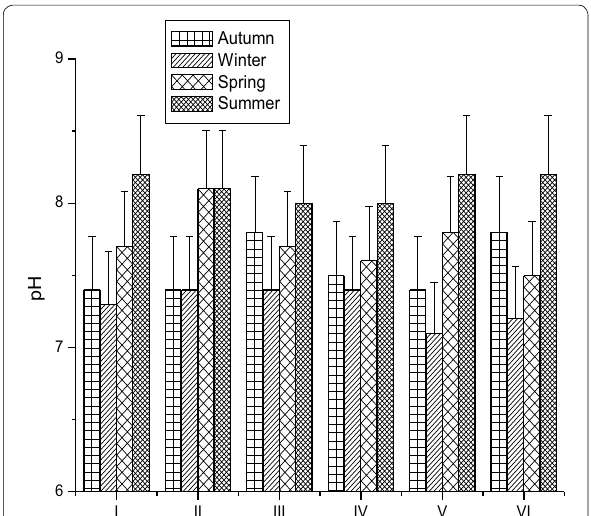
Fig. 8 Spatial and temporal variations of free carbon dioxide (mg/L)